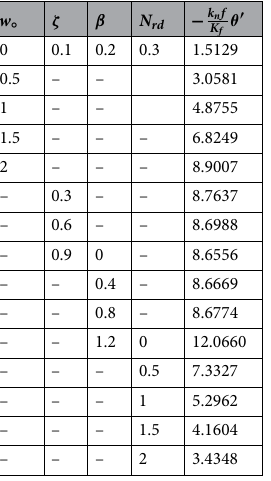
Table 4. Effects of suction, navier slip parameter, reciprocal of critical shear stress and radiation on Nusselt 1 for TiO 2 0.05 and c water . number. When φ = = −